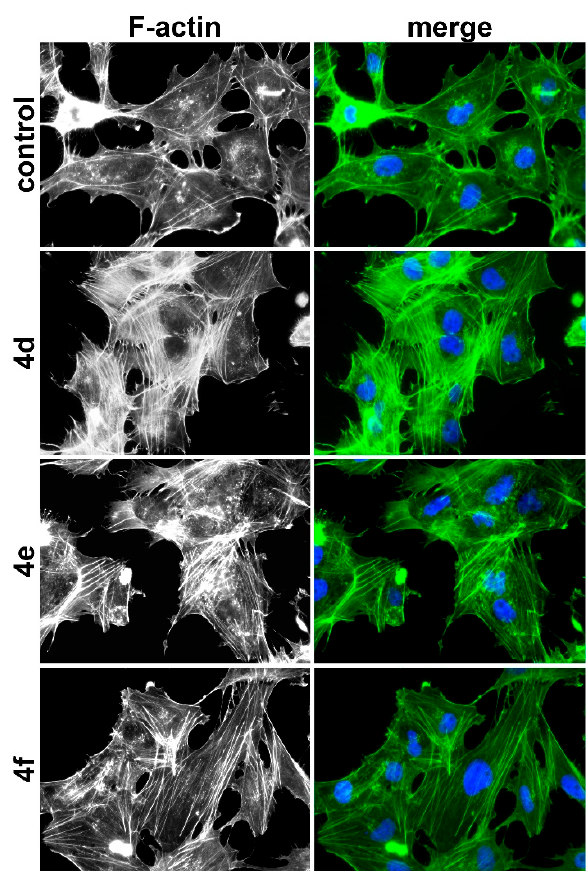
Figure 5. Effect of 4d (0.5 µM), 4e (1.5 µM), 4f (4 µM), and vehicle (DMSO) on the organization of the actin cytoskeleton in 518A2 melanoma cells after 24 h exposure. Fluorescence labeling of filamentous actin (F-actin; green). Nuclei were counterstained with DAPI (merge, blue). Pictures are representative of two independent experiments (400× magnification).